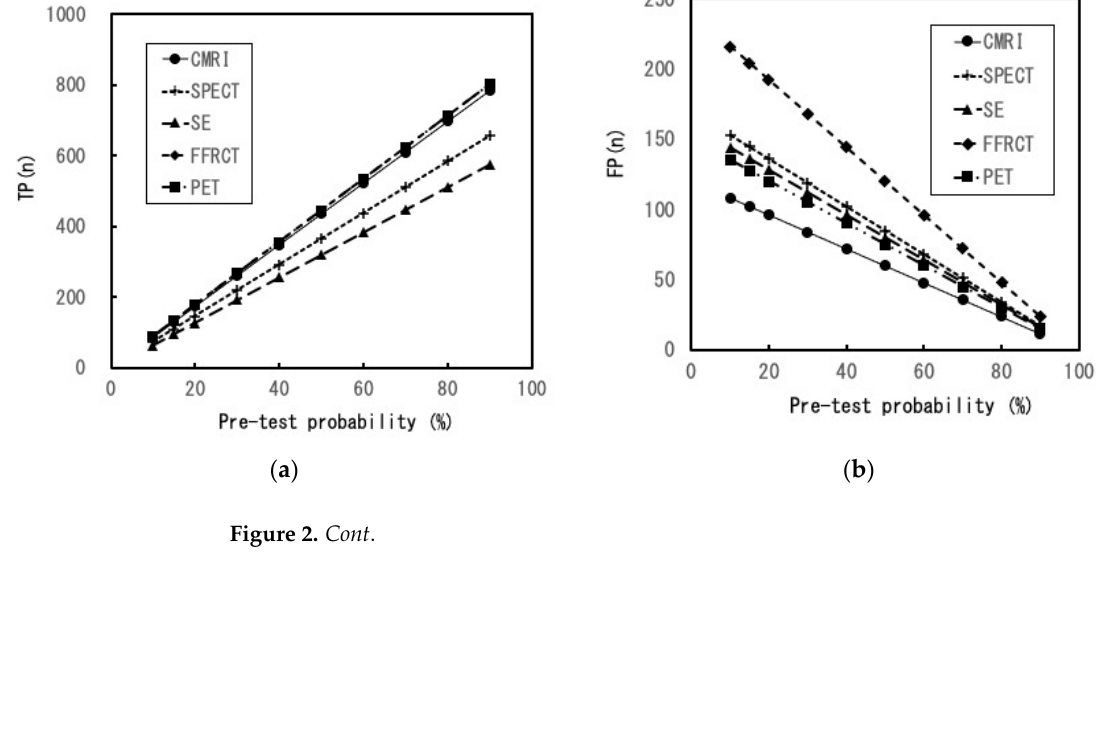
( d ) Figure 2. Sensitivity analysis (1). ( a ) Changes in the number of TP results with various pre-test prob- abilities of CAD. The number of TP PET and FFRCT results is equivalent; ( b ) changes in the number of FP results with various pre-test probabilities of CAD; ( c ) changes in the number of FN results with various pre-test probabilities of CAD. The number of FN PET and FFRCT results is equivalent; ( d ) changes in the number of TN results with various pre-test probabilities of CAD. CMRI: cardiac magnetic resonance imaging, SPECT: single-photon emission computed tomography, SE: stress echocardiography, FFRCT: fractional flow reserve derived from coronary computed tomography angiography, PET: positron emission computed tomography, TP: true positive, FP: false positive, FN: false negative, TN: true negative, CAD: coronary artery disease.